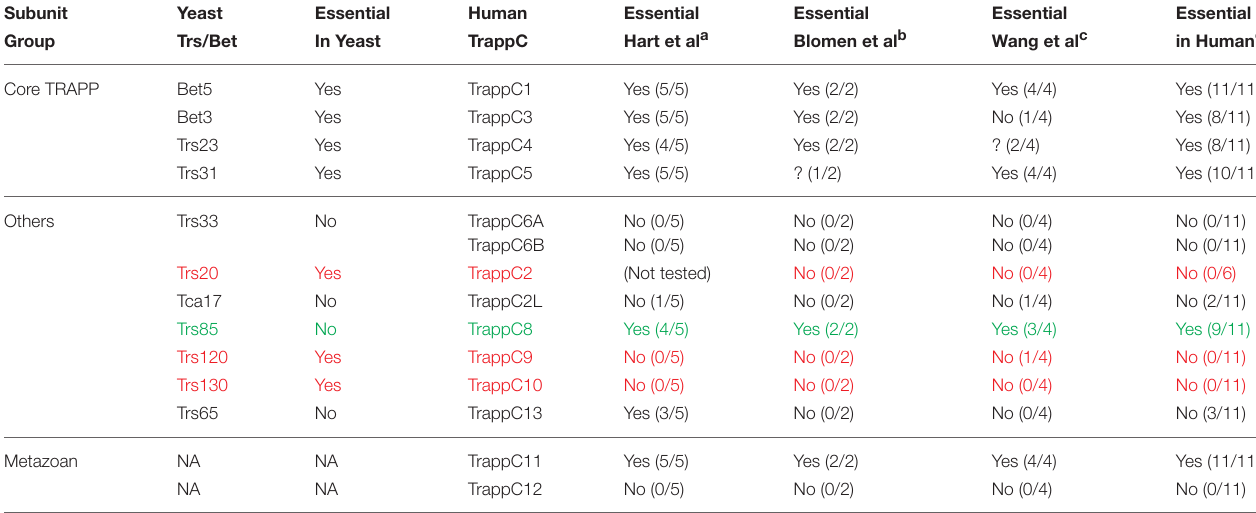
TABLE 2 | TRAPP Subunit Essentially. Subunit Yeast Essential Human Essential Essential Essential Essential Group Trs/Bet In Yeast TrappC Hart et al a Blomen et al b Wang et al c in Human d Core